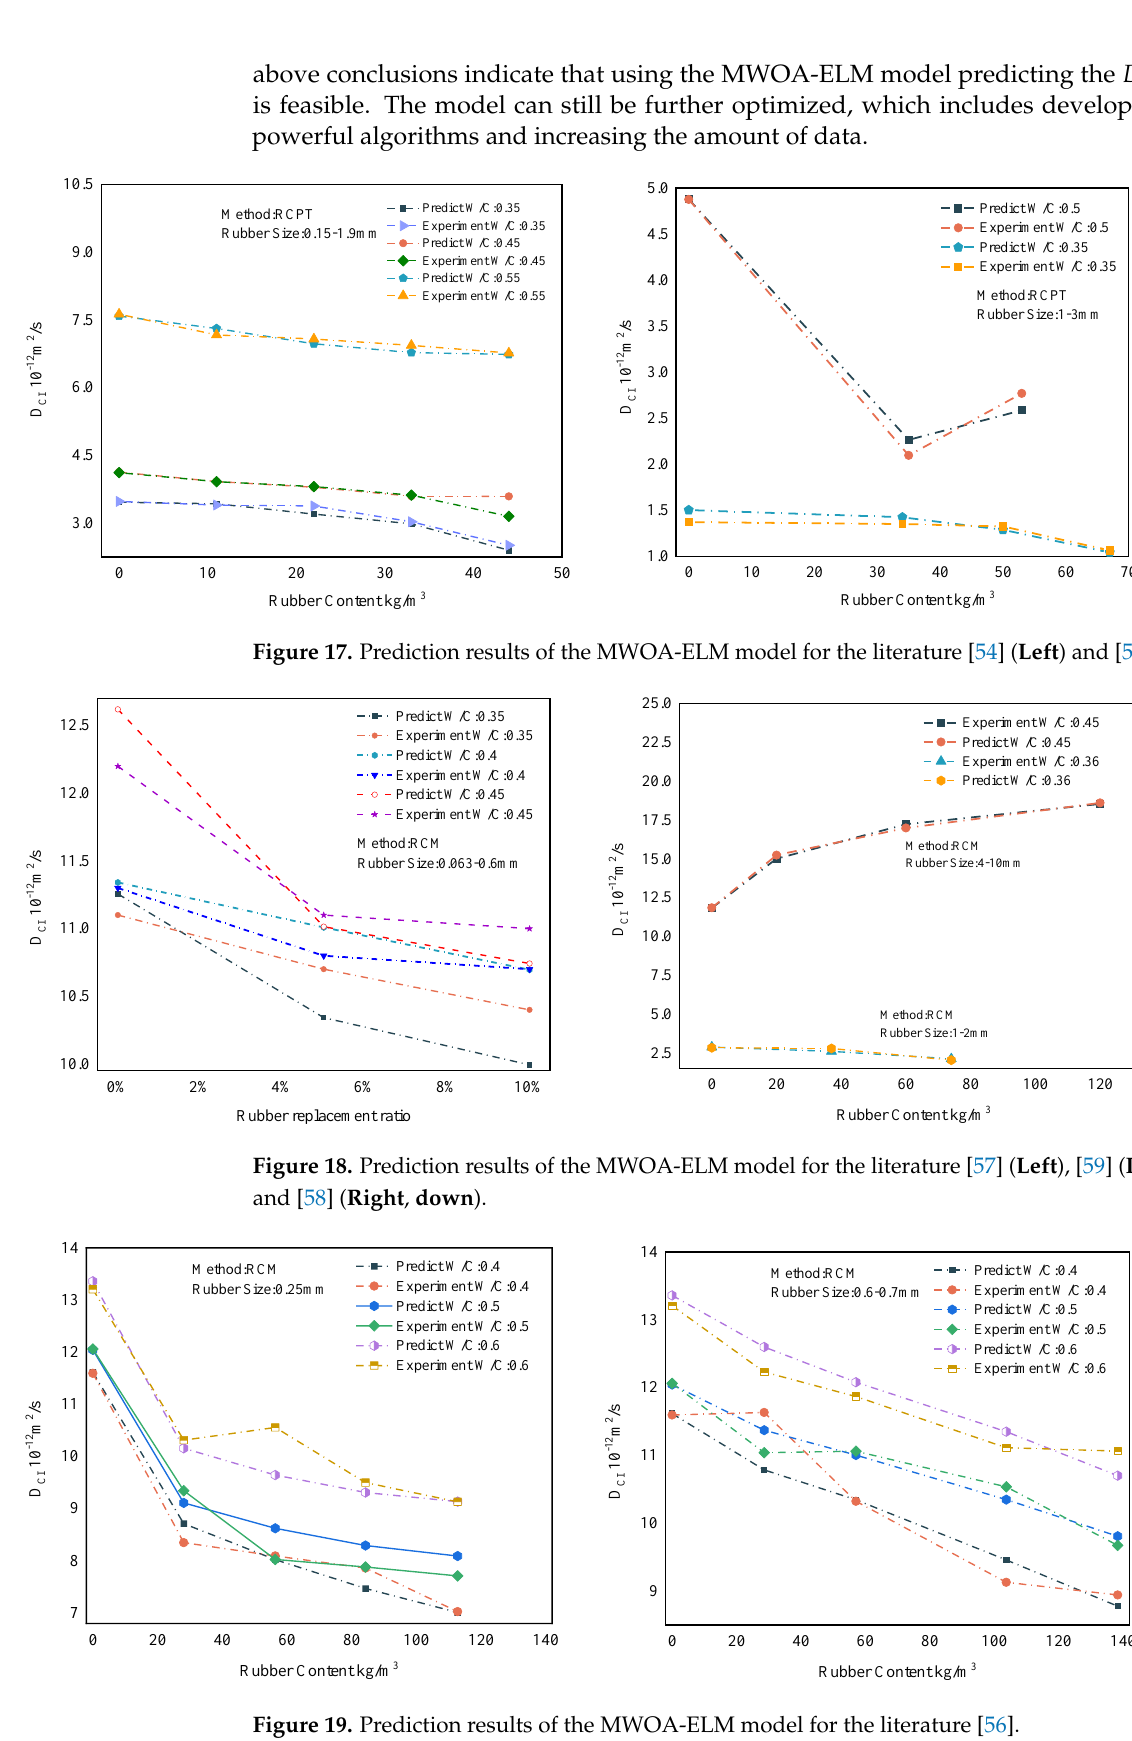
Figure 20. Prediction results of the MWOA-ELM model for the literature [22]. 6.5. Comparative Analysis with Other Models To further verify the MWOA-ELM model’s reliability, this study in troduces a multi- ple linear regression model for comparison [90]. Since the MRL model is similar to the ML model in that it also studies the effects of multi-factor interactions, it is compared with the MWOA-ELM model. Figure 21 represents the regression analysis results of the MRL model. The results of the evaluation indicators for the MWOA-ELM (Mean of overall model results under five-fold cross-validation) model and the MRL model are shown in Table 9. Obviously, MWOA-ELM is superior to the MRL model.